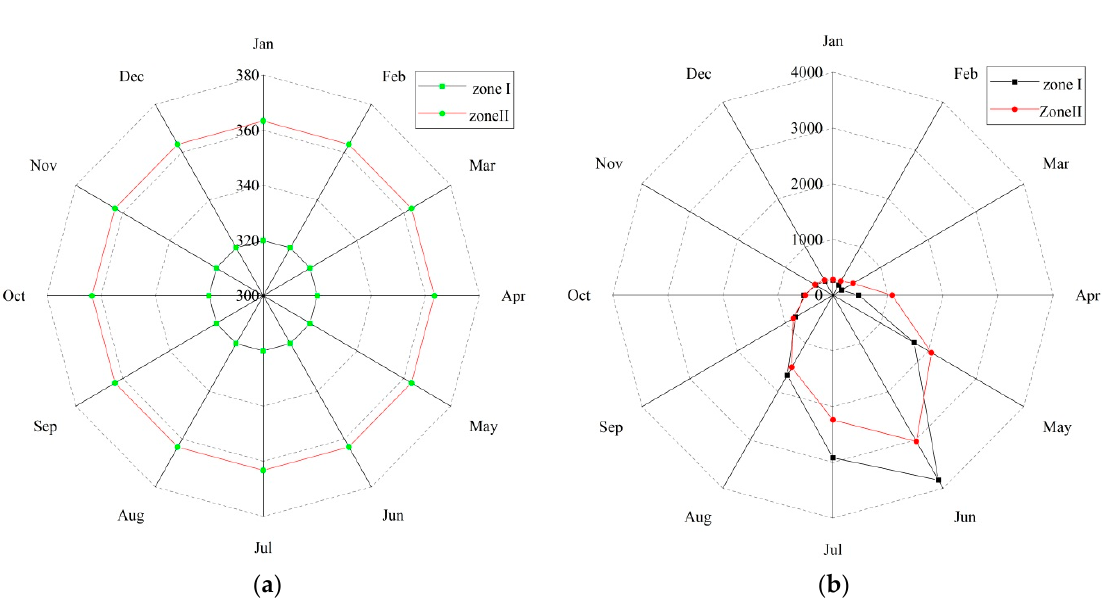
Figure 21. Annual number of drought events in Zone I.